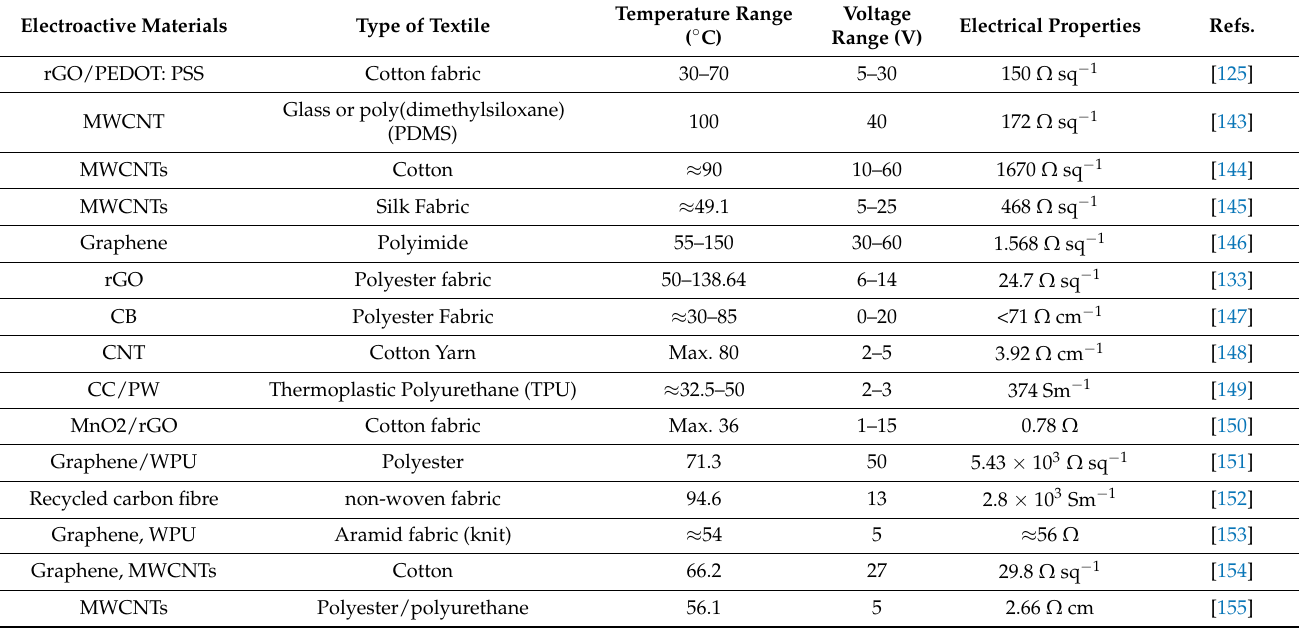
Figure 7. Thermal insulation property of graphene-/polymer-coated textile-based multi-layer fabric heating element with aramid fabric: ( a , d ) measuring layer of triple- and quadruple-layer samples. ( b , e ) surface temperature of triple- and quadruple-layers of samples with various applied voltages, and ( c , f ) IR images of each sample at 30 V [142]. Table 5. Summary of carbonaceous heating textile.